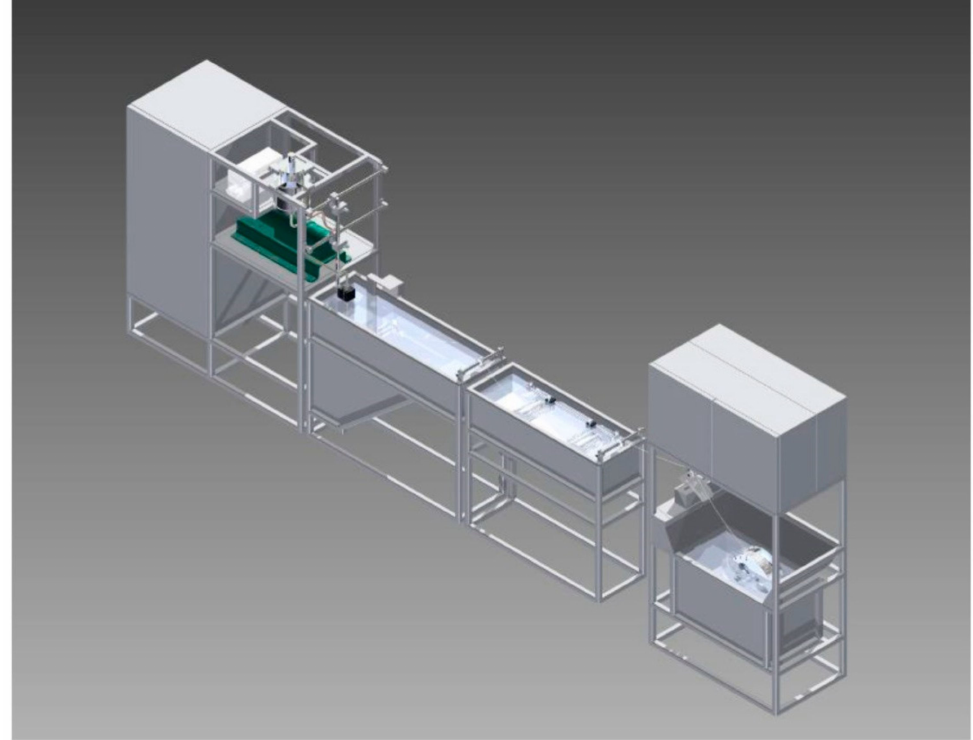
Figure 4. Schematic depiction of a hollow fiber membrane fabrication system. Reprinted from